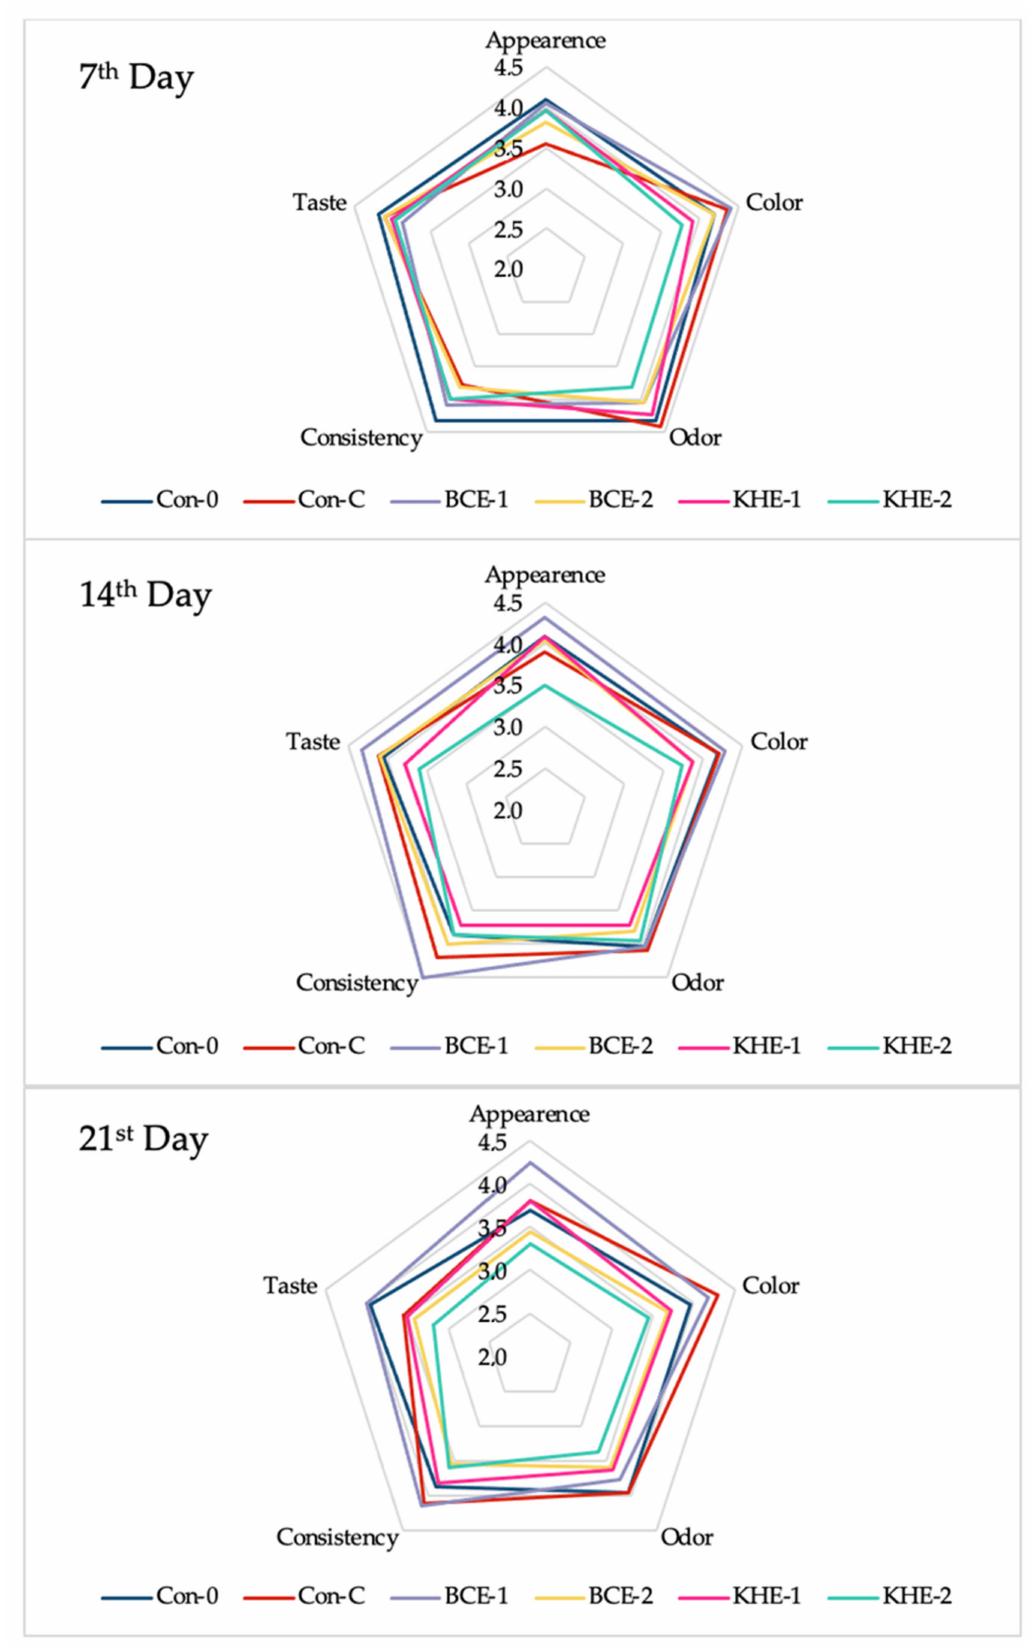
Figure 2. Effect of extract addition on sensory properties of analyzed frankfurter